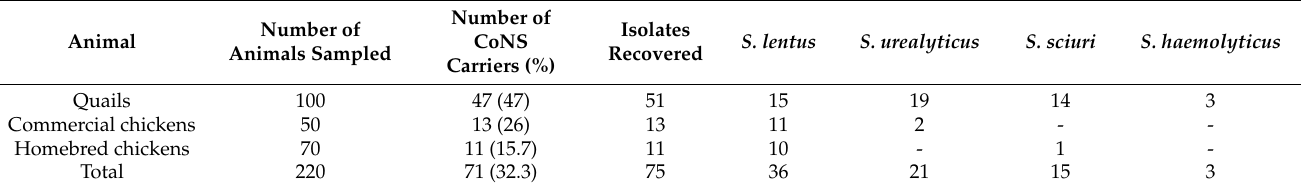
Table 1. Number of animals sampled, frequency and diversity of CoNS species detected among healthy